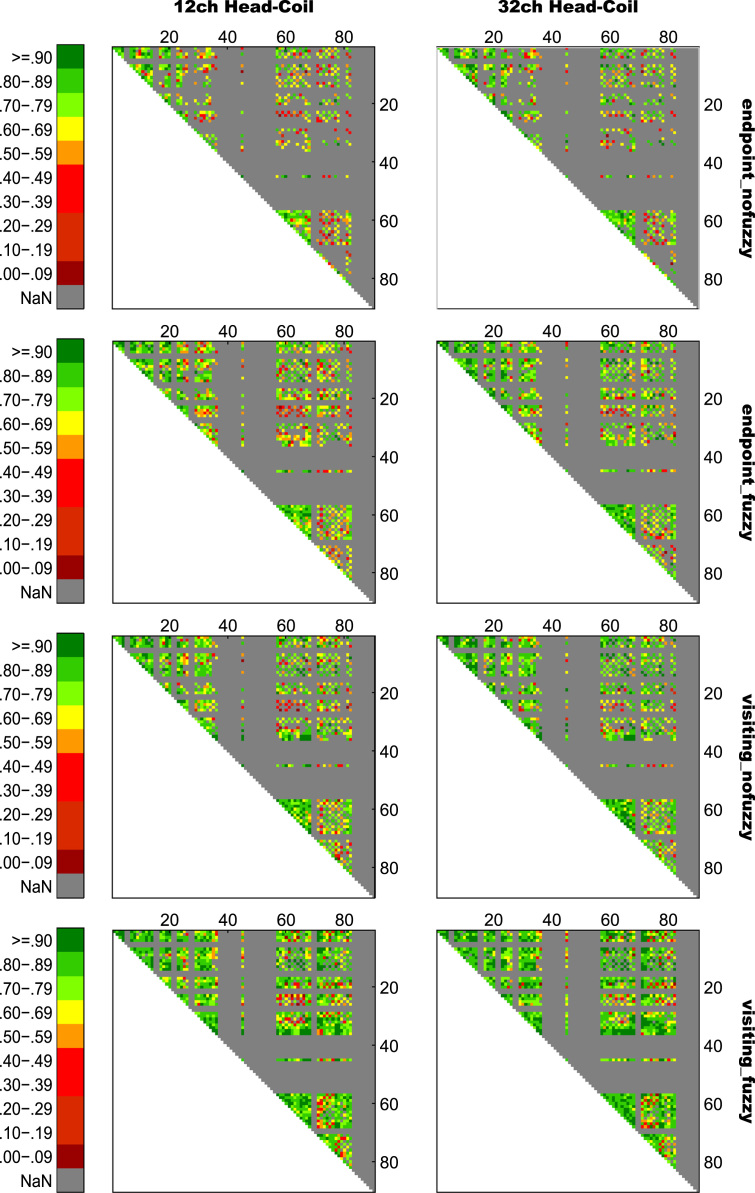
Seed-specific ICC(2,1) values for all connections of Model 4, estimating the between-session reproducibility of all eight variants of type of head-coil×streamline selection variant. Numbers on the x- and y-axis refer to AAL seed numbers. For visualization purposes, negative ICC(2,1) values were set to zero (0.13% of values).